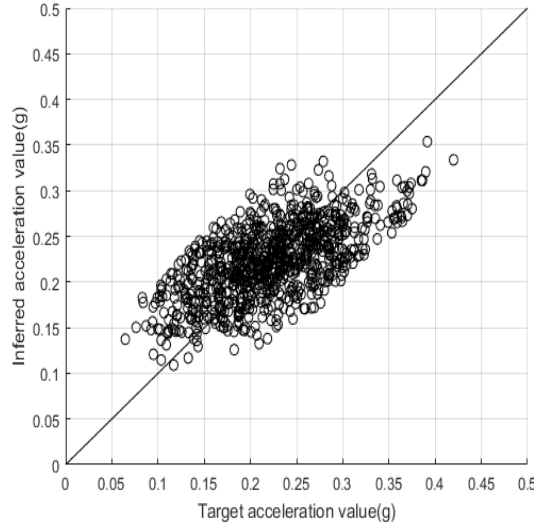
Figure 10. Model accuracy for spectral-yield displacement 𝑆 𝑎𝑦 with 20 building characteristics.